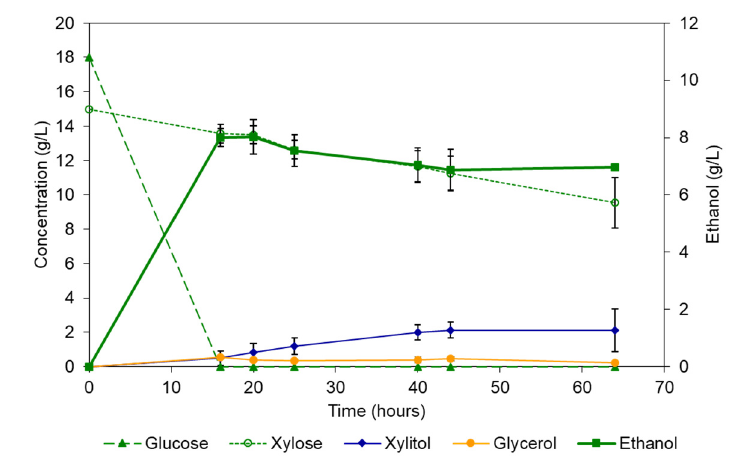
Figure 2. Time course for fermentation of synthetic medium using S. cerevisiae Ethanol Red. Concentrations (g/L) of glucose, xylose, xylitol and glycerol and production (g/L) of ethanol are shown.